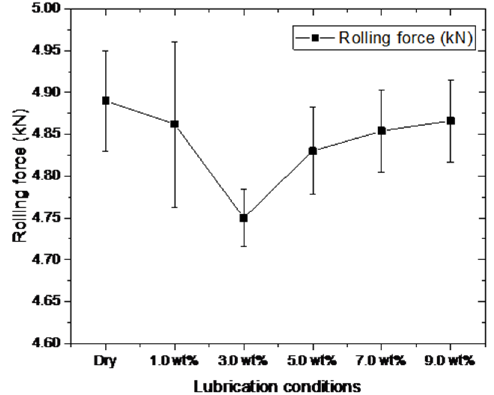
Figure 2. The rolling forces of copper foils during micro rolling experiments with different lubrication conditions (50% reduction).